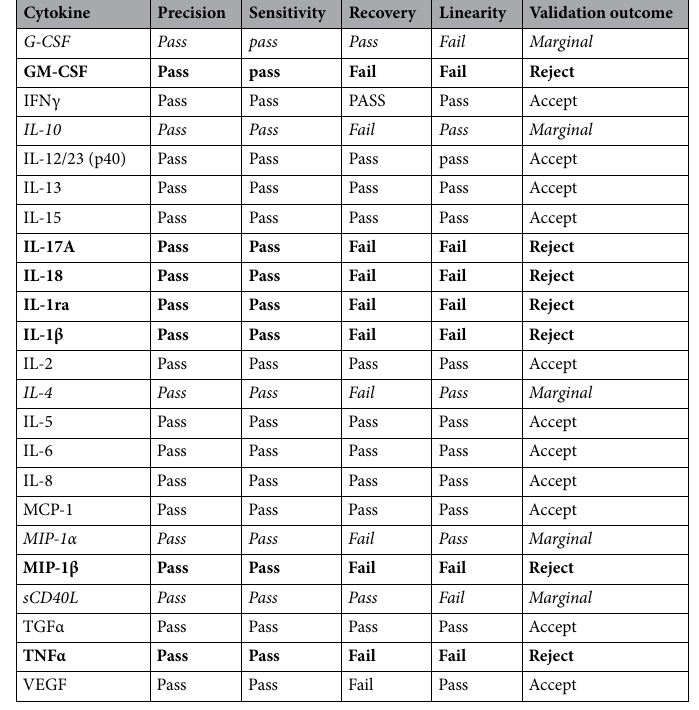
Table 1. Validation outcomes for cytokines measured in healthy NHP serum. Regular text = accept; italicized = marginal; bold =